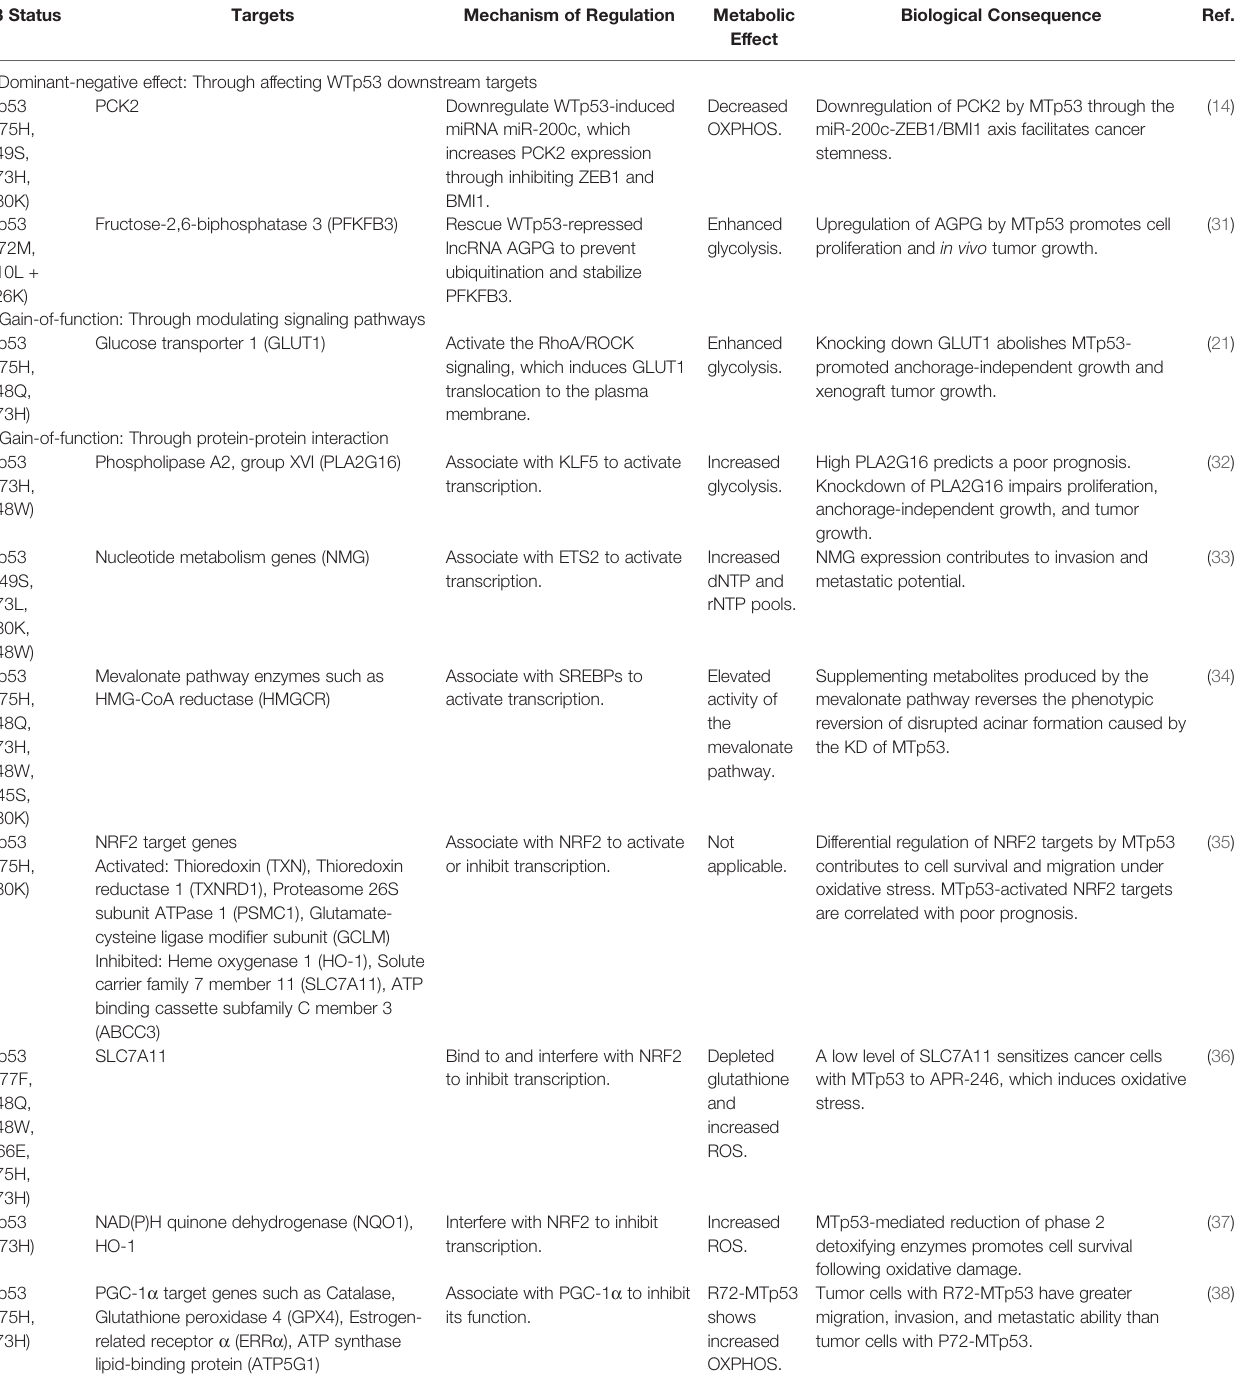
TABLE 2 | Metabolic targets indirectly regulated by mutant